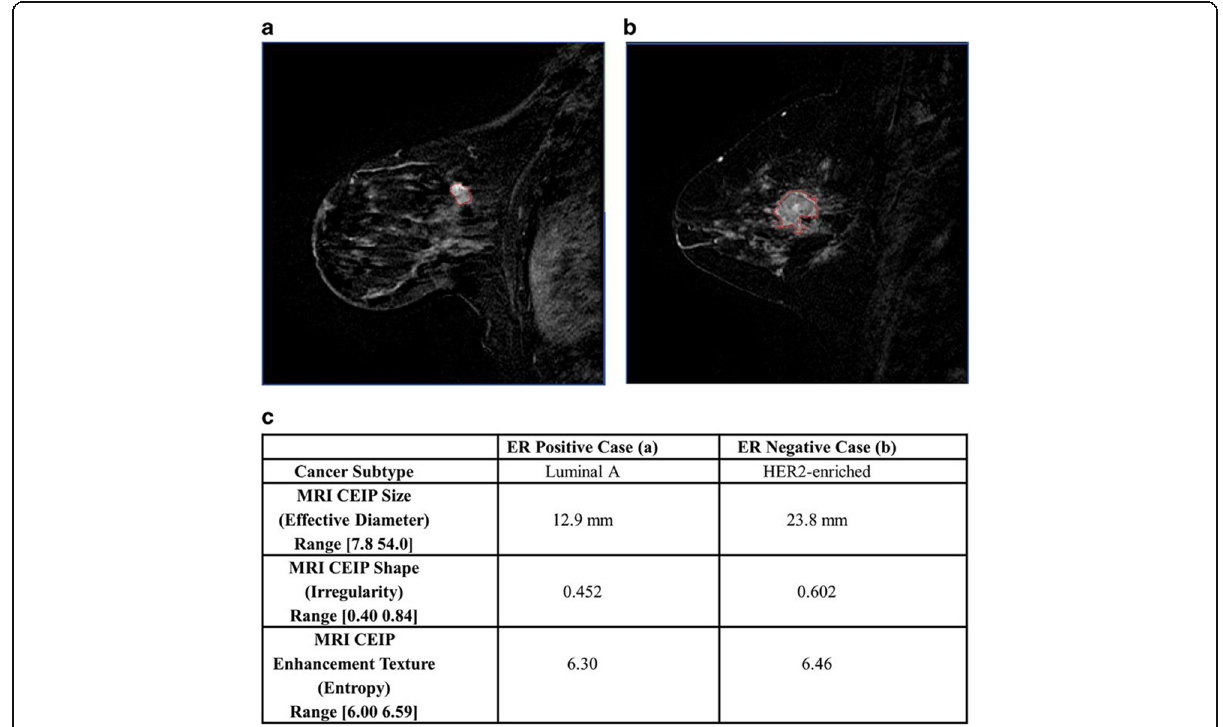
Fig. 1 The computer segmentation method in example cases of one estrogen receptor positive tumor and one estrogen receptor negative tumor. The tumor segmentation outlines are shown along with computer-extracted image phenotype (CEIP) values (and ranges) for size, irregularity, and contrast enhancement heterogeneity. Reprinted under a Creative Commons license from: NPJ Breast Cancer. 2016;2. pii: 16012. Epub 2016 May 11. Quantitative MRI radiomics in the prediction of molecular classifications of breast cancer subtypes in the TCGA/TCIA data set. Li H, Zhu Y, Burnside ES, Huang E, Drukker K, Hoadley KA, Fan C, Conzen SD, Zuley M, Net JM, Sutton E, Whitman GJ, Morris E, Perou CM, Ji